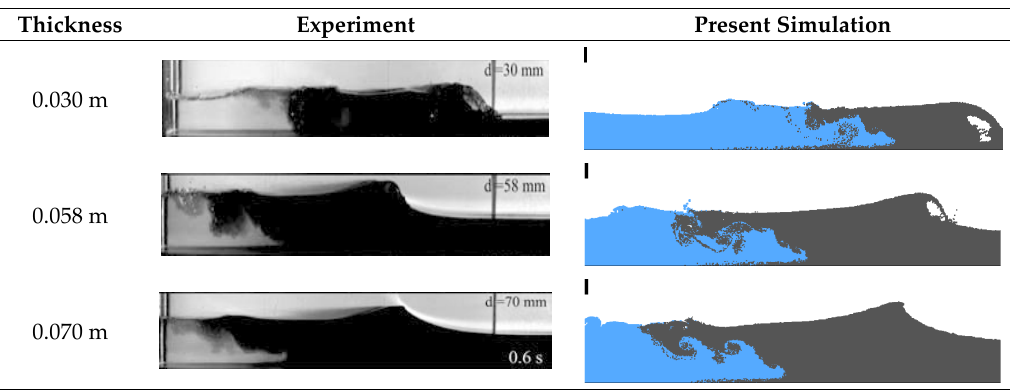
Figure 9. Comparison between the experiment and numerical simulation with various thicknesses of the soil bed at 0.6 s.